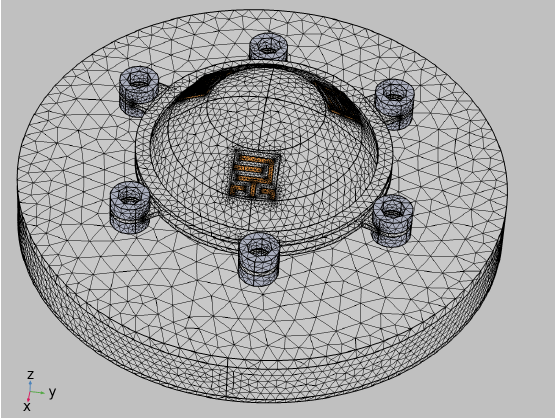
Figure 5. Mesh used in our COMSOL